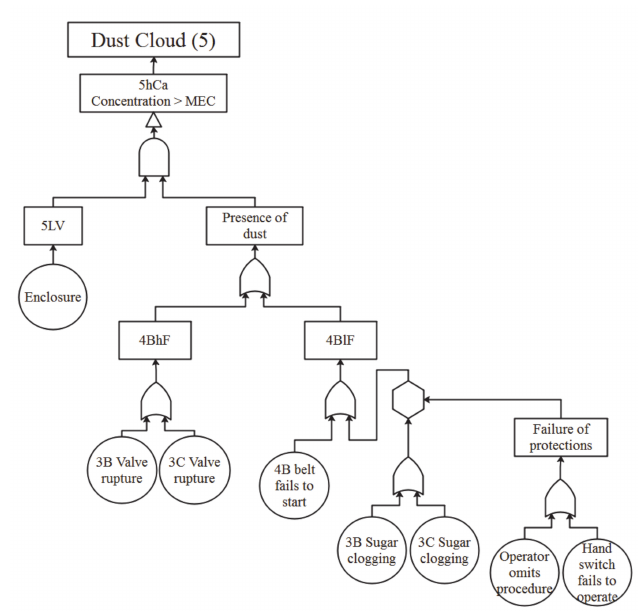
Figure 5. Fault tree for the dust cloud formation top event. 5LV—low volume inside node 5; 4BhF—high sugar flow inside node 4B; 4BlF—low sugar flow inside node 4B.